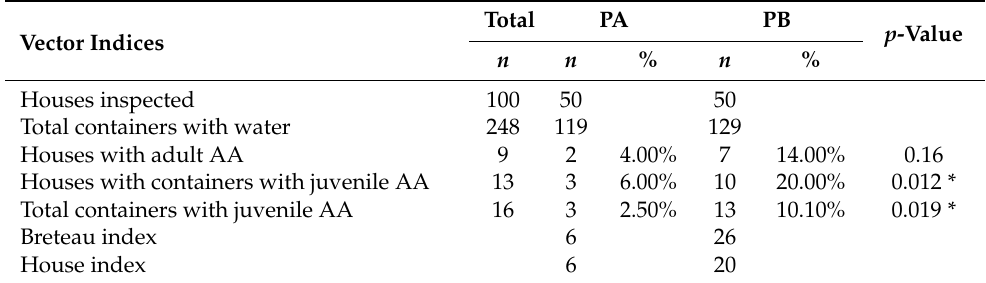
Table 2. Aedes aegypti (AA) indices in August–September 2014 for households in Puerto Ayora (PA) and Puerto Baquerizo Moreno